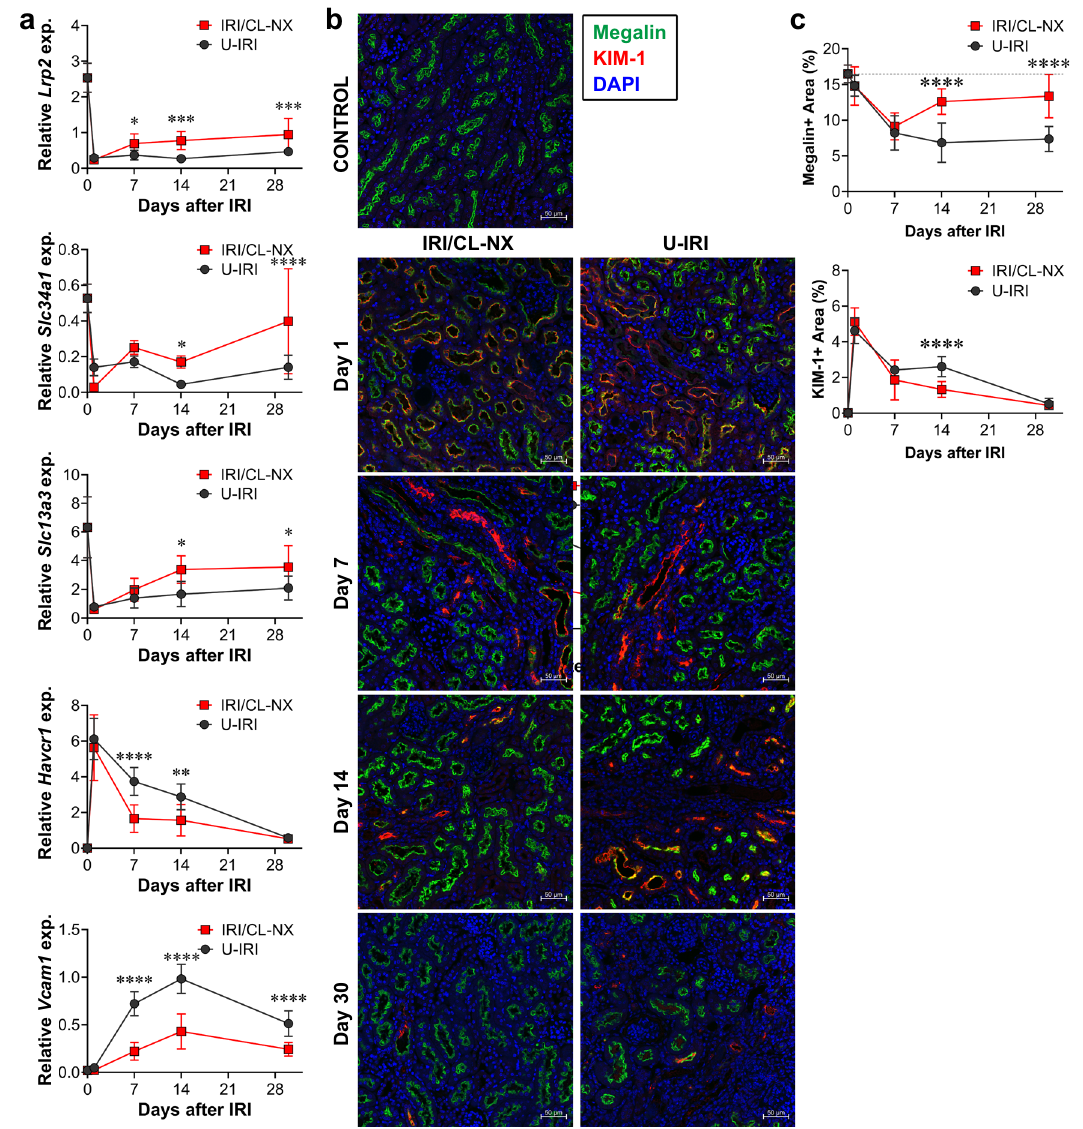
Fig. 2 | U-IRI leads to failure of tubular redifferentiation and exaggerated Vcam1 expression. Wild-type mice were subjected to 27min of ischemia/reper- fusion injury (IRI) with contralateral nephrectomy (IRI/CL-NX) or unilateral IRI (U- IRI) and sacri fi ced on day 1, 7, 14, and 30 after injury. The injured kidneys and normal control kidneys (de fi ned as day 0) were harvested. a Quantitative RT-PCR analysis for Lrp2 (megalin), Slc34a1 (sodium-dependent phosphate transporter 2A, Napi2a), Slc13a3 (sodium-dependent dicarboxylate transporter, NaDC3), Havcr1 (kidneyinjurymolecule-1,Kim1),and Vcam1 (vascularcelladhesionmolecule-1)was performed onwhole-kidneyRNA.Dataarepresented asmean±SD. n =10kidneys/ time point/model. Two-way ANOVA was summarized in Supplementary Table 1.